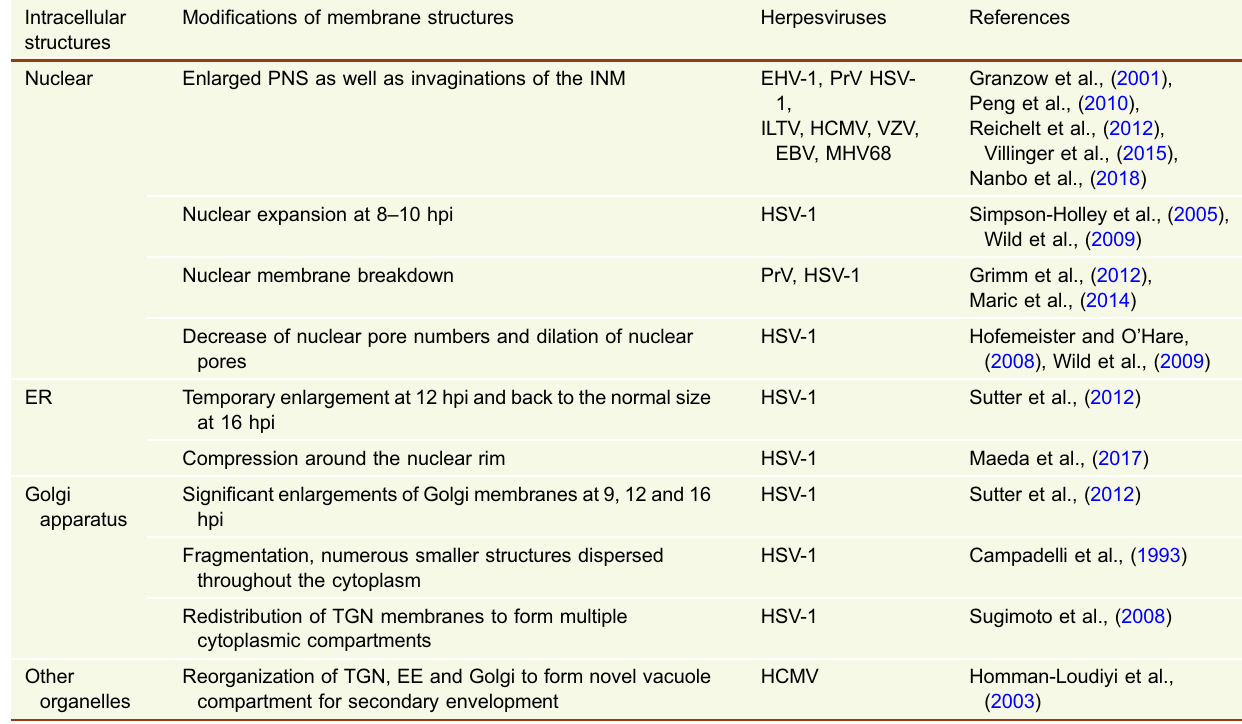
Table 1. Overview of the membrane modi fi cations during herpesvirus assembly and egress Intracellular